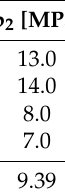
Figure 3. The location of each simplex centre for each run, together with the position of the local optimum. Table 4. The location of the starting points (simplexes’ centres) for each run, and the position of the local optimum.